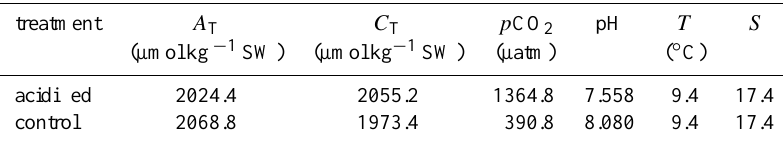
Table 1. Summary of carbon system parameters: A T , total alkalinity, C T , total dissolved inorganic carbon (both measured), p CO 2 , partial pressure of CO 2 , calculated pH T (total scale), T , Temperature and S , Salinity.